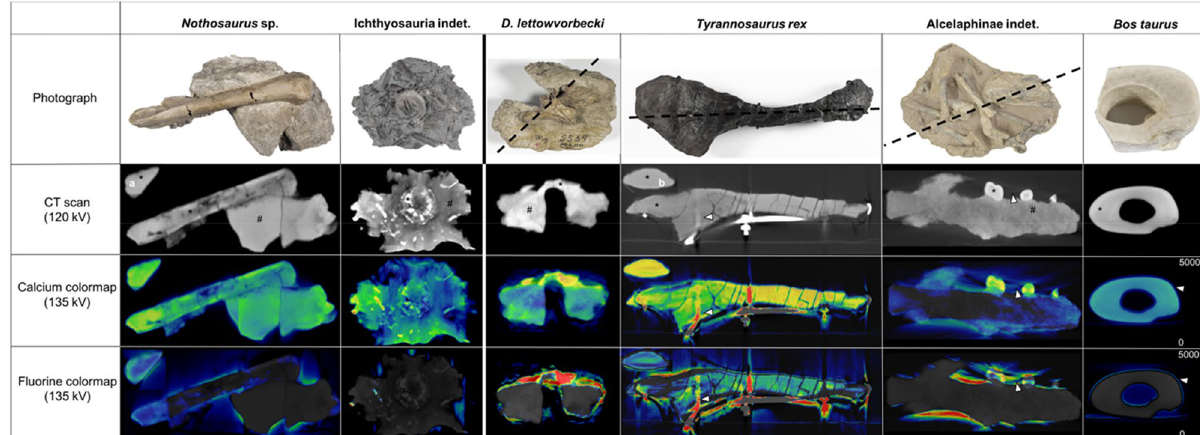
Figure 3. Photographs and CT images and DECT material maps of bone samples from the calibration and the sediment-embedded test objects. In the horizontal, the objects are divided into marine and terrestrial animals and listed in order of their geological time periods. The photographs and the black dotted lines in the first row indicate the cross-sectional plane of the CT and DECT images of the respective object. The photograph of the Bos taurus leg bone was taken after bone fragment removal. In the second row, bone tissue is indicated with a black asterisk (*), and sediment is indicated with a black hashtag (#). DECT material maps show detected calcium (third row) and fluorine (fourth row) in the investigated specimens. Red indicates high concentrations of the investigated element measured in Hounsfield units (color bar in the right lower corner). As the Tyrannosaurus rex (T. rex) and Nothosaurus sp. specimens were relatively large compared to the other specimens, additional axial planes are illustrated to show the calcium and fluorine distribution within the bone ( a , b , respectively). The demonstrated axial plane of the T. rex specimen is at the level of the bone fragment, which was removed for invasive bone analysis, allowing for image-mass spectrometry correlation. White arrowheads indicate observed artefacts, partly caused by the attached metal frame (haemal arch of T. rex ).